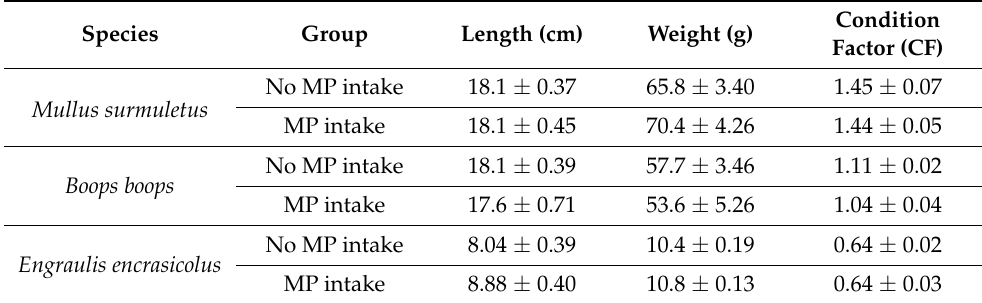
Table 1. Biometric characteristics of each studied species. Species Group Length (cm)